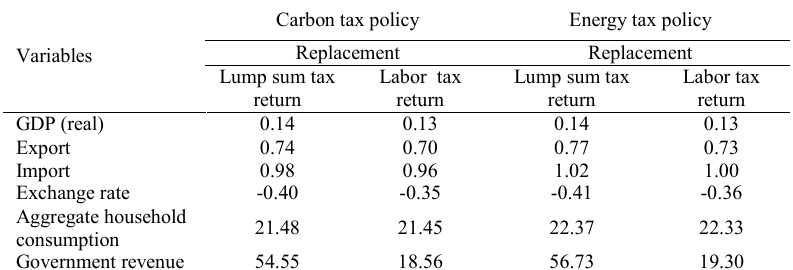
Table 2: Aggregate impacts of both taxes: the case of 15% carbon reduction (% changes from benchmark value)